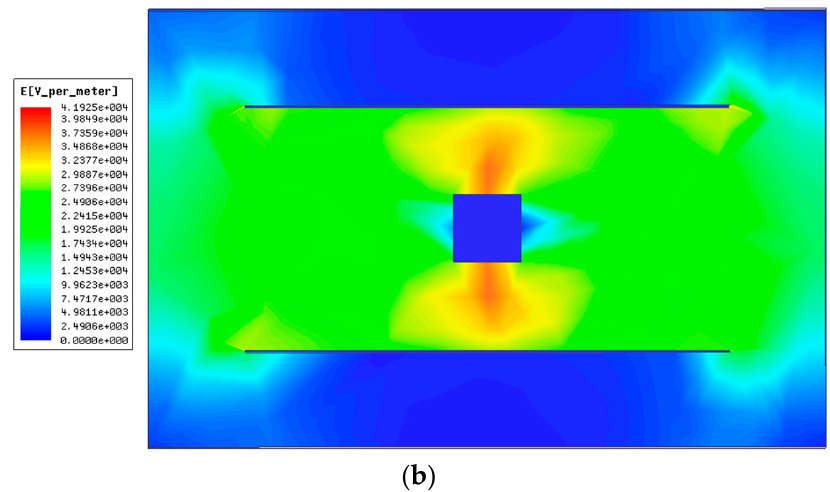
Figure 2. Distribution of eletronic lines and potential cloud. ( a ) Distribution of electronic lines; ( b ) Potential cloud.